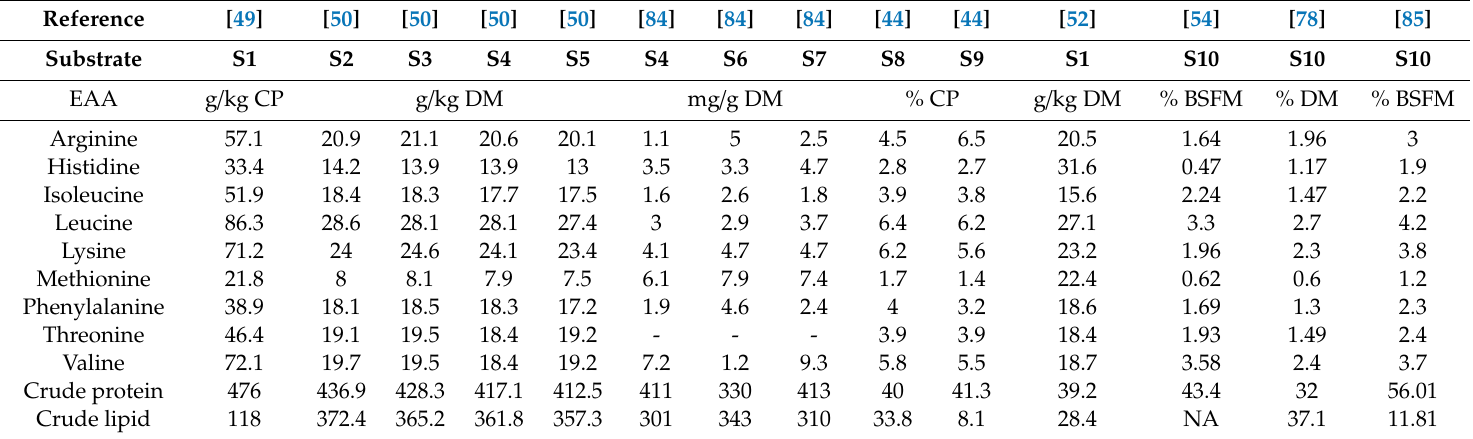
Table 3. Essential amino acid profile of BSFL reared on di ff erent